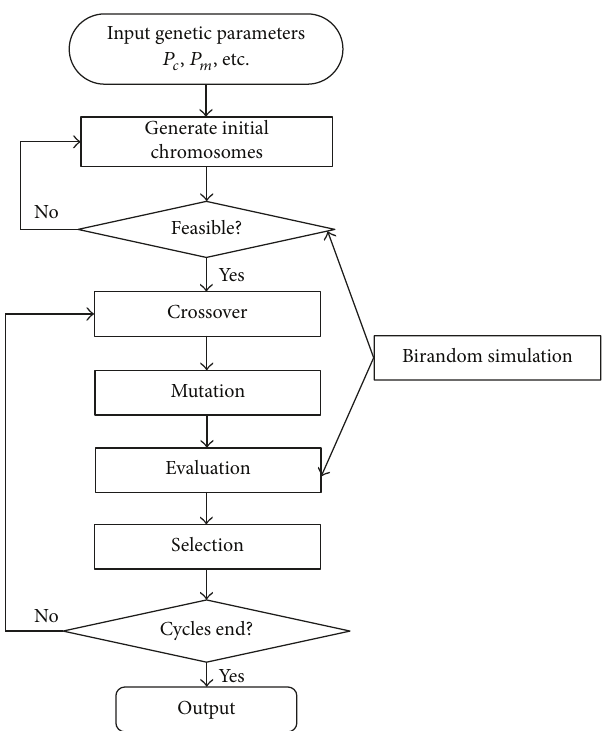
Figure 2: The flowchart of the birandom simulation-based GA.